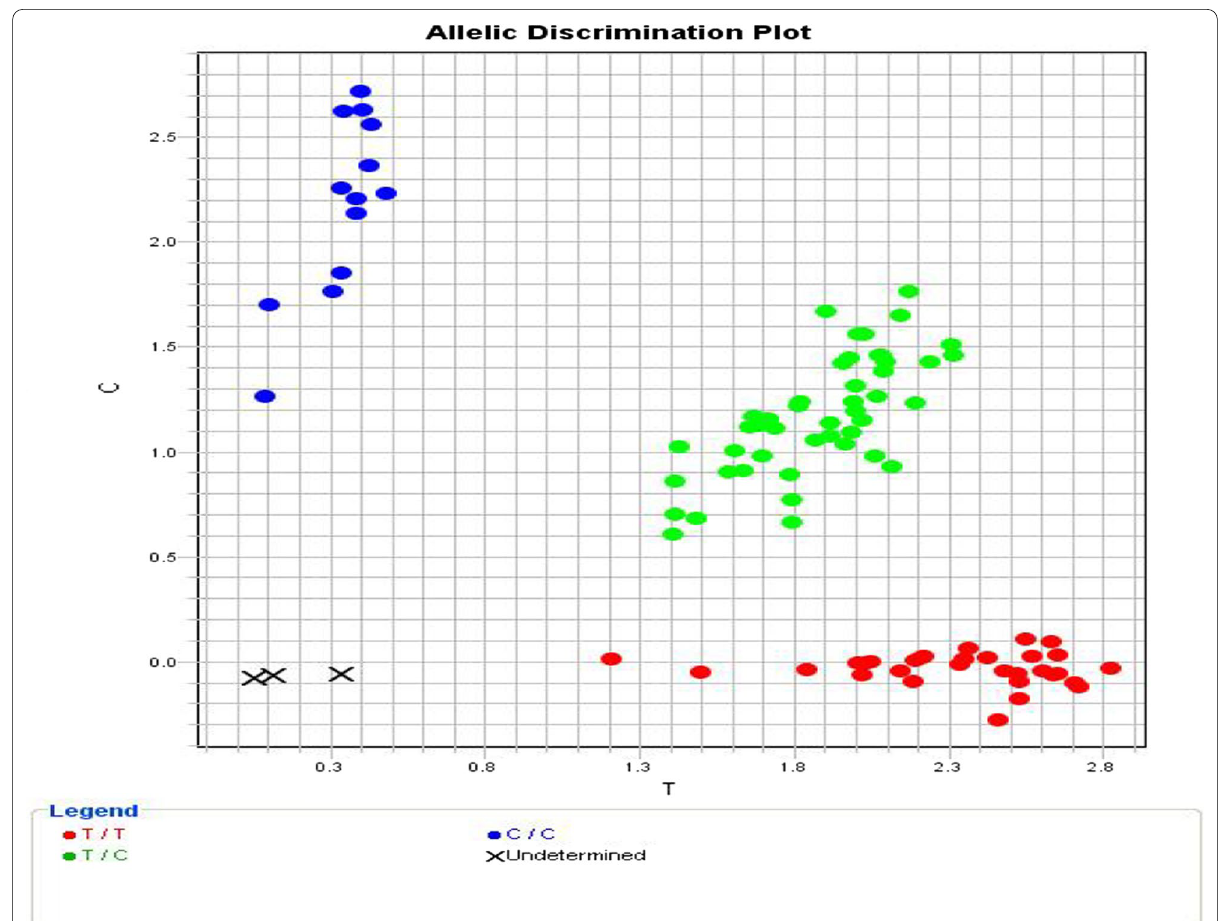
Fig. 3 Allelic discrimination plot showing CC, CT and TT genotypes of IGF-1 rs6214(C/T) polymorphism